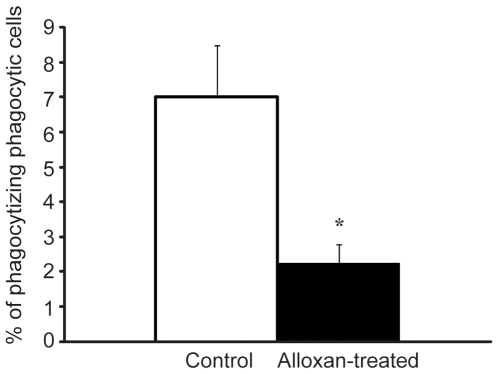
Decreased phagocytic ability of leukocytes in diabetic mice.Percentage of phagocytic leukocytes phagocytizing LPS-coated fluorescent beads in the peritoneal cavity in control (n = 5) and alloxan-treated diabetic (n = 4) mice. *p<0.05. Data are means ± SEM.